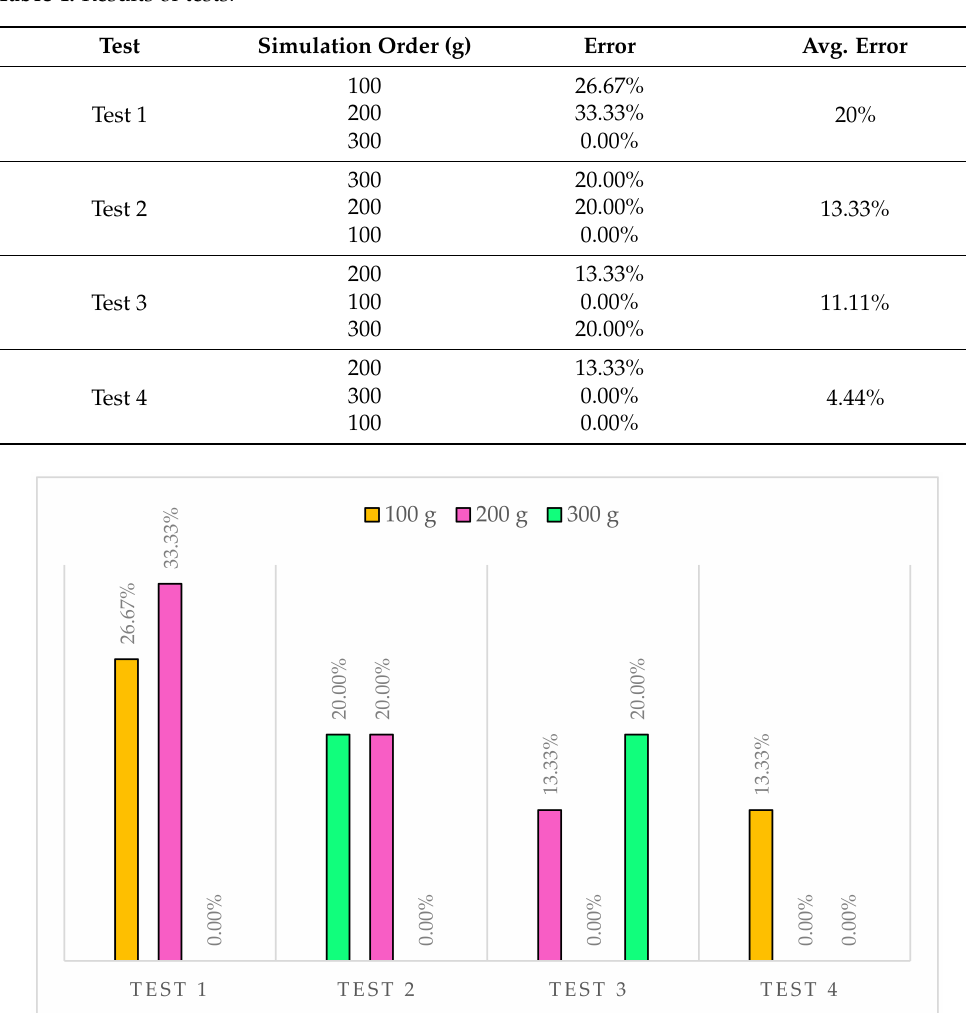
Table 4. Results of